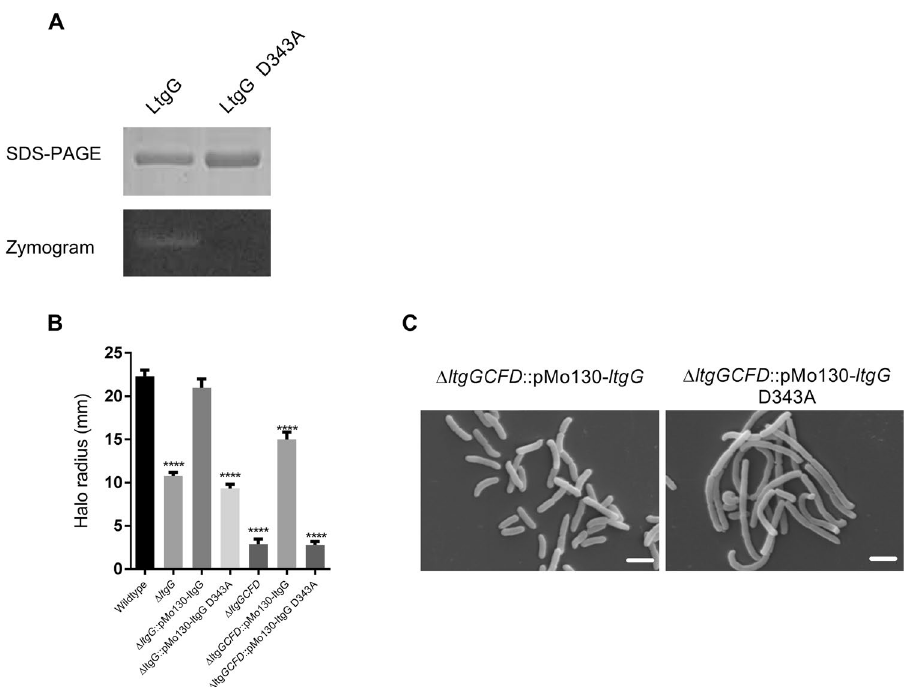
Figure 7. D343A mutation in LtgG abolished its activity and failed to complement mutant’s phenotype. ( A ) Zymography of wildtype LtgG and D343A variant (see Fig. S3 for uncropped images). ( B ) Complementation of swimming motility in ltgG mutants. ( C ) SEM micrographs of ∆ ltgGCFD and complemented mutants. Scale bar is 2 µ m. A one-way ANOVA was performed comparing LtgG mutant strains with wildtype (n = 7), **** p <